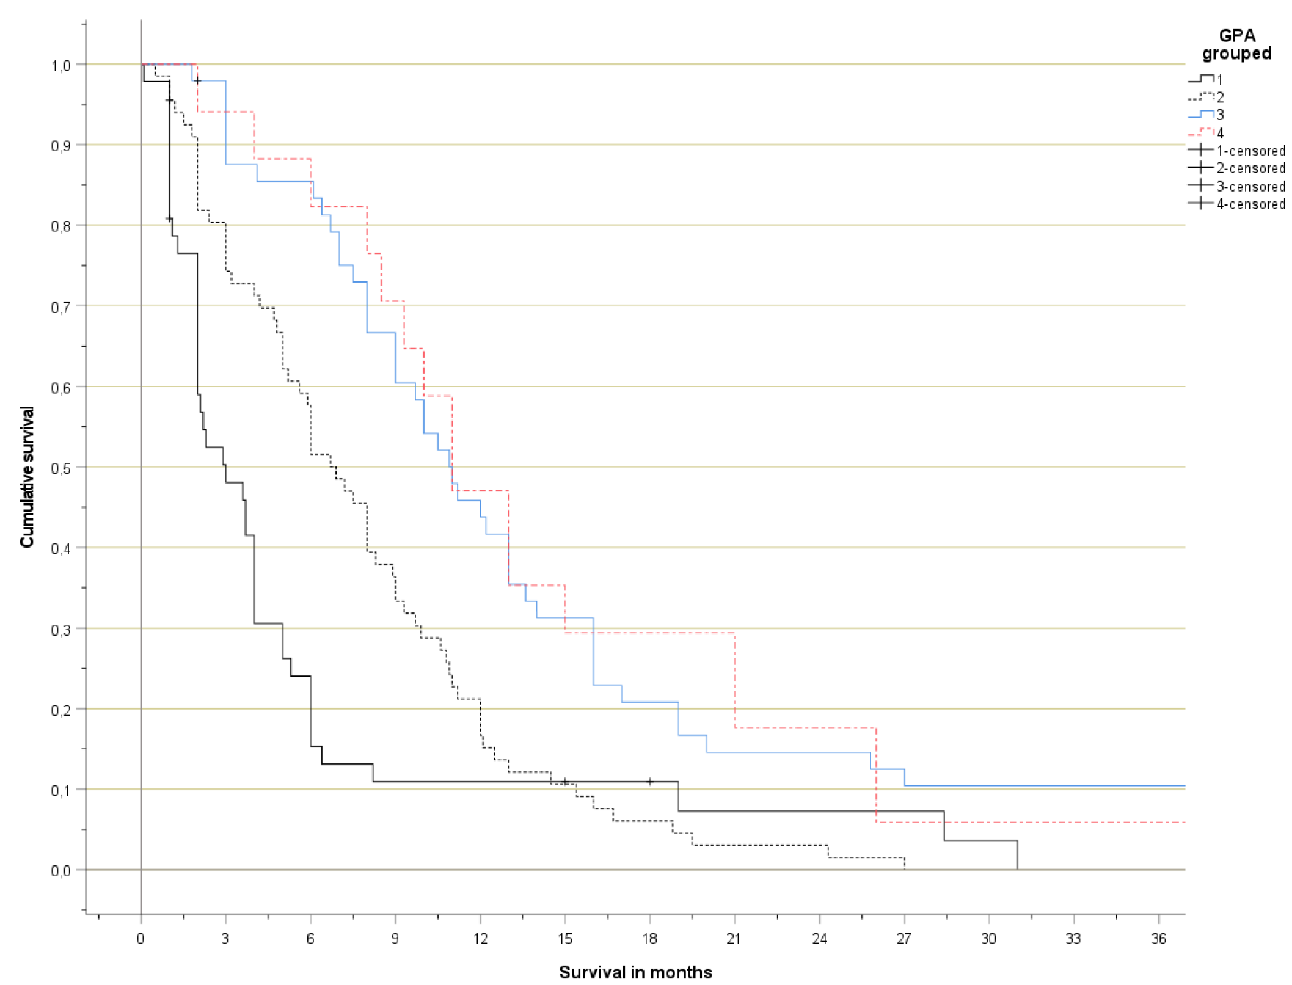
Figure 2. Actuarial overall survival (Kaplan-Meier curves, log-rank test pooled over all strata p < 0.001; p < 0.05 for all pairwise comparisons except group 3 versus 4).